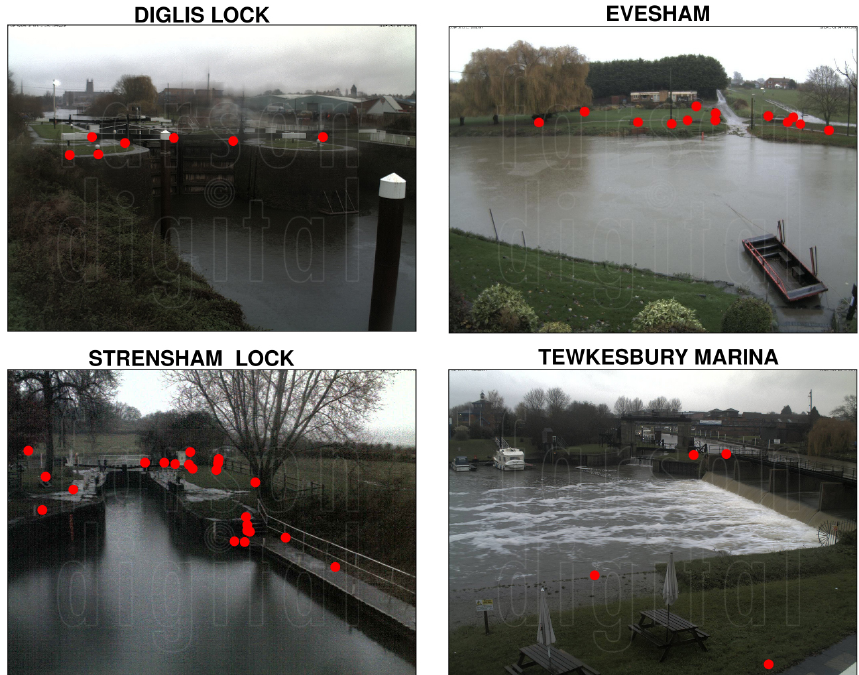
Figure 5. Sample camera image for each location with the measured landmarks annotated by red dots. Photo: Farson Digital Watercams. Table 2. River-camera location and specific dataset